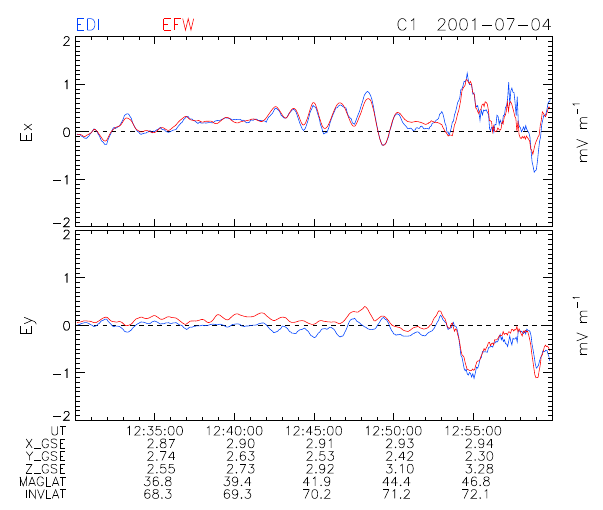
Fig. 7. Detail of part of the data in Fig. 6, showing agreement between EFW (red) and EDI (blue) to the level of a fraction of a mV/m in the inner magnetosphere.